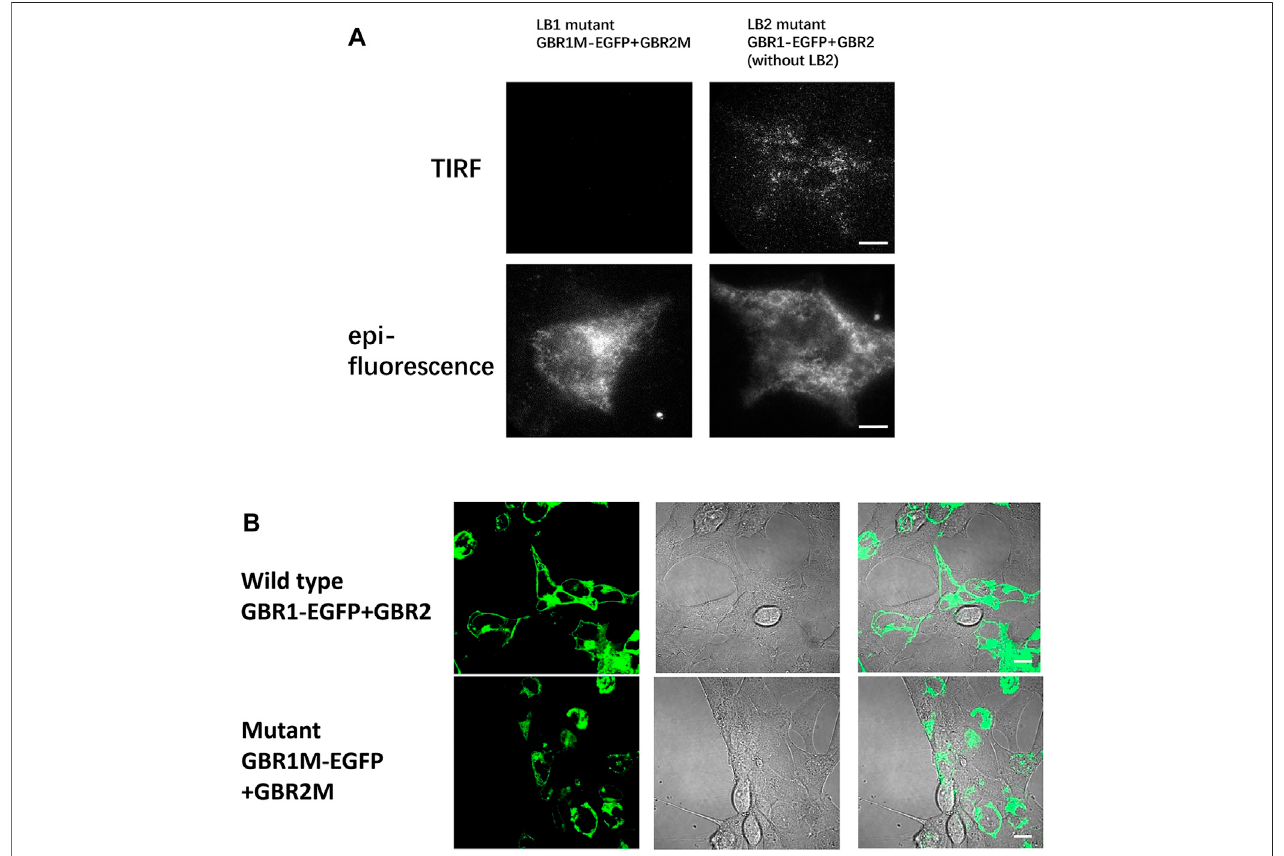
FIGURE 3 | Mutation in the LB1 region effectively prevented receptor dimerization. (A) In HEK293 cells, GBR1M-EGFP and GBR2M (with LB1 mutation) were transfected at the same time (left) . GBR1M-EGFP remained in the endoplasmic reticulum, and no fl uorescent spots were observed on the cell membrane due to the inhibitionofdimerization.ForthecelltransfectedwithmutantGBR1-EGFPandmutantGBR2thatremovedtheLB2region (right) ,theycouldstillformaheterodimerand dock on the membrane. (B) Confocal microscopy was used to observe HEK293 cells transfected with GBR1-EGFP and GBR2 (upper row) or mutant GBR1M- EGFP, and GBR2M (lower row) . Scale bars: 10 μ m.